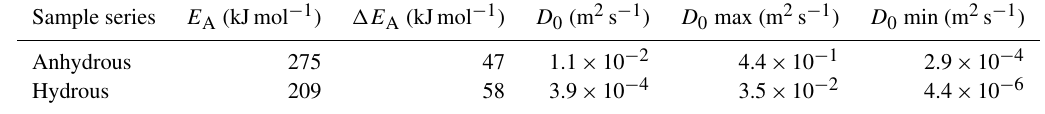
Table 5. Activation energies of CO 2 and D 0 values for the leucititic melt. Sample series